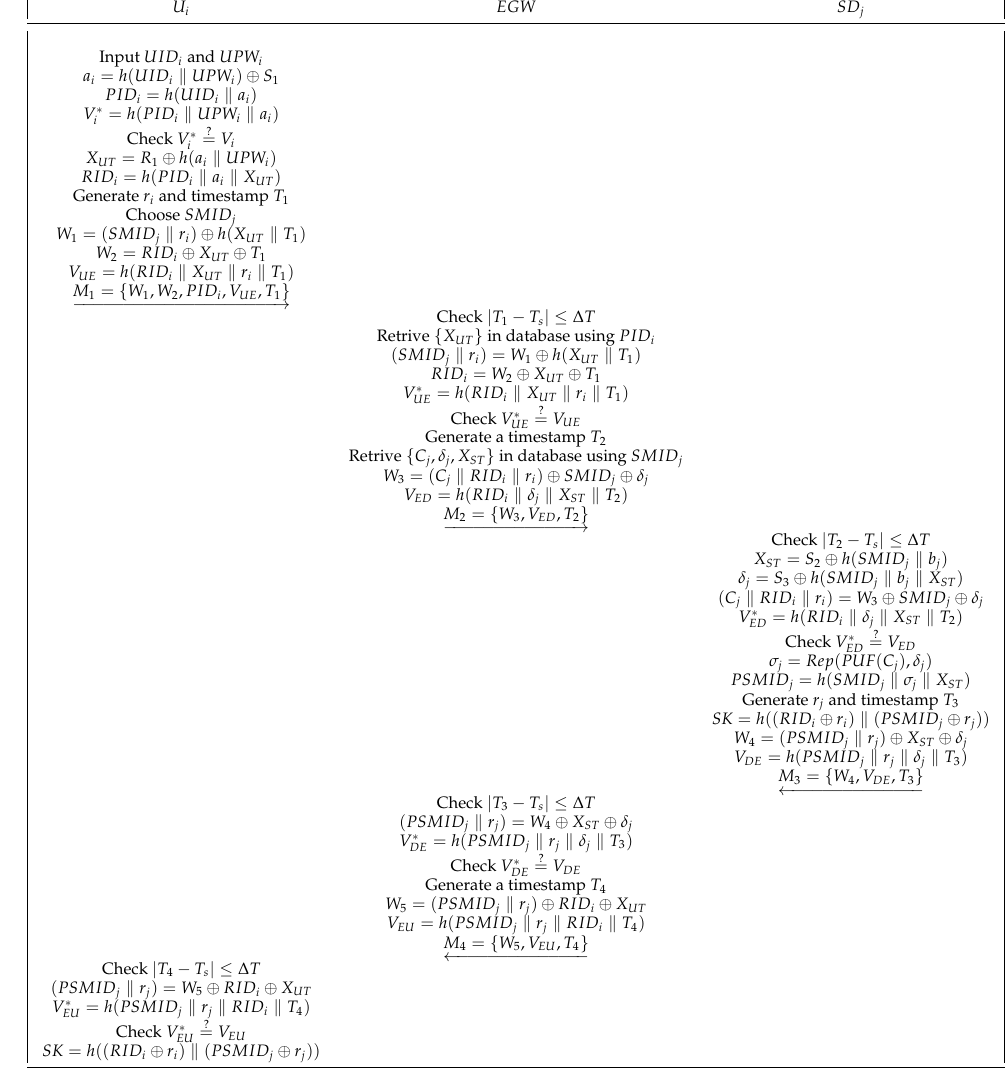
Figure 5. Login and authentication